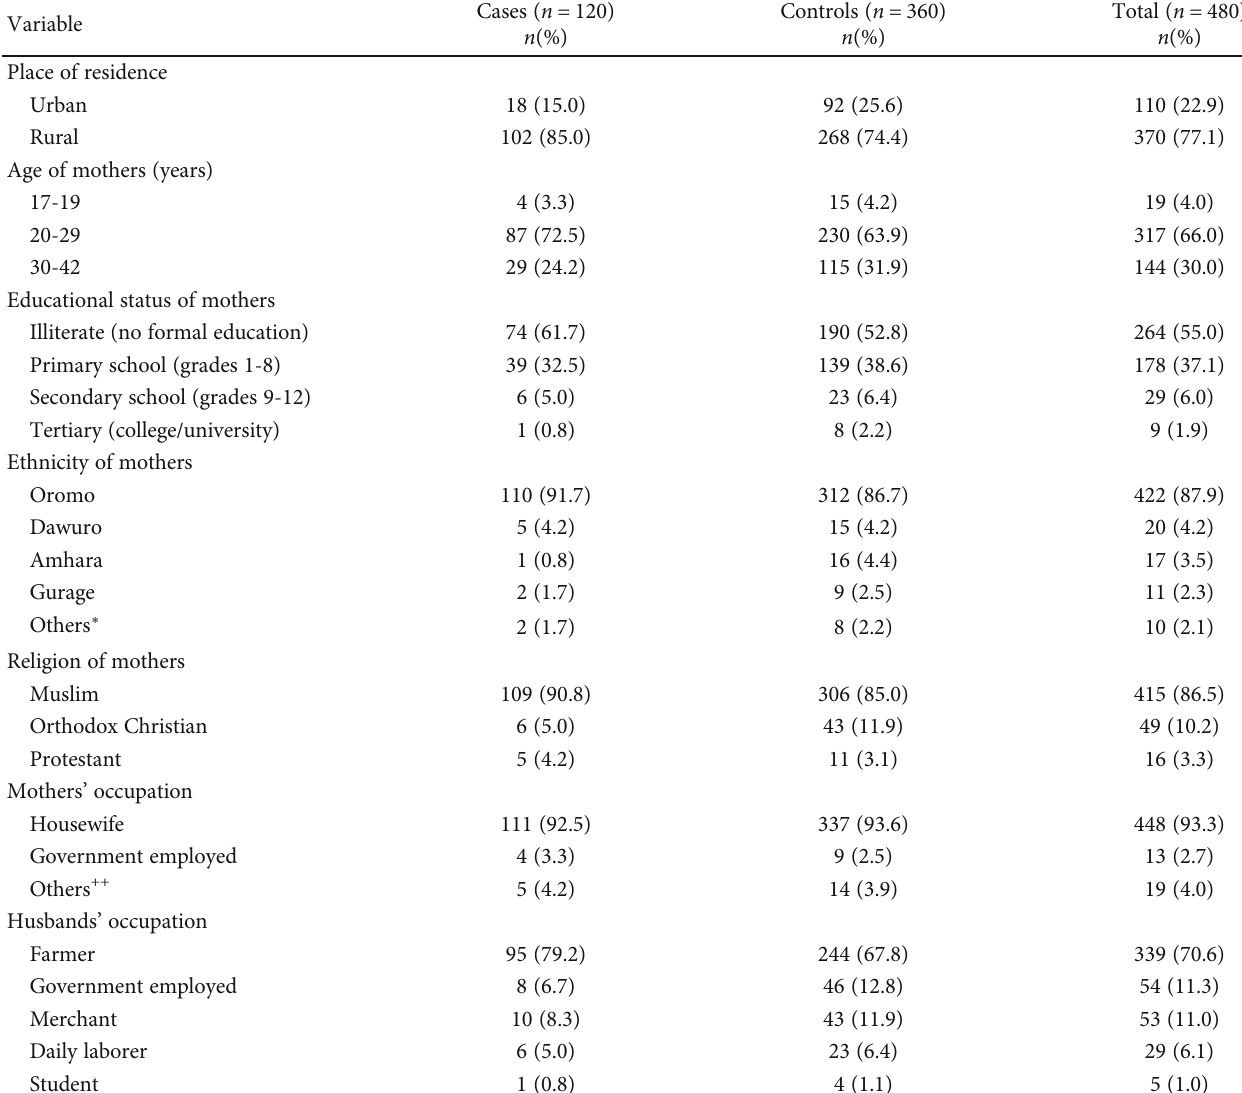
Table 1: Sociodemographic characteristics of the respondents for the case-control study, Jimma Zone, Southwest Ethiopia.